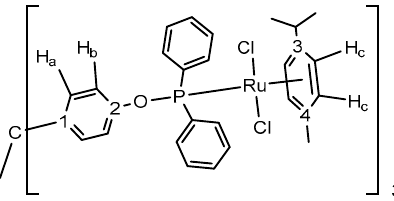
Figure 7. Labeling scheme used for 1 H and 13 C{ 1 H} NMR assignments.